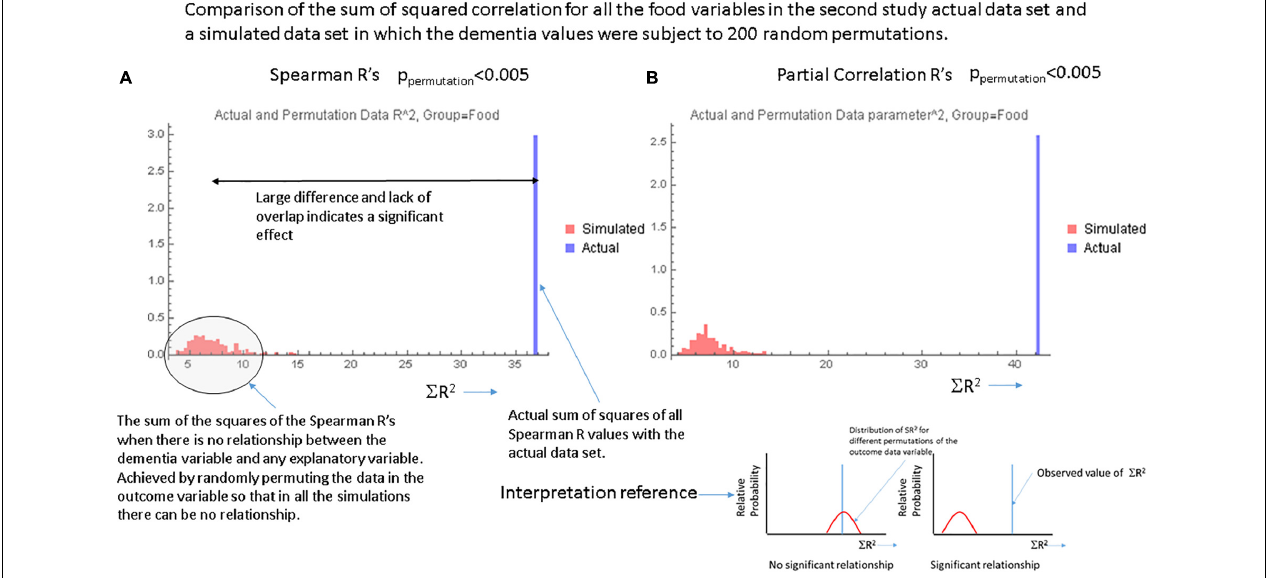
FIGURE 3 | Data from the P R 2 test for global significance with (A) the Spearman correlation coefficients and (B) the partial correlation coefficients for each food variable. In each case the single bar at the right represents the actual sum of R 2 over all food variables in the actual data set. The smaller bars to the left in each graph show the results of computing the sum of the values of R 2 over 200 random permutations of the data in the dementia variable. These simulations essentially show the values of P R 2 in the absence of any relationship-the null hypothesis. The inset at the lower right shows a cartoon of the findings expected when there is or is not a significant relationship between the explanatory variables and the outcome